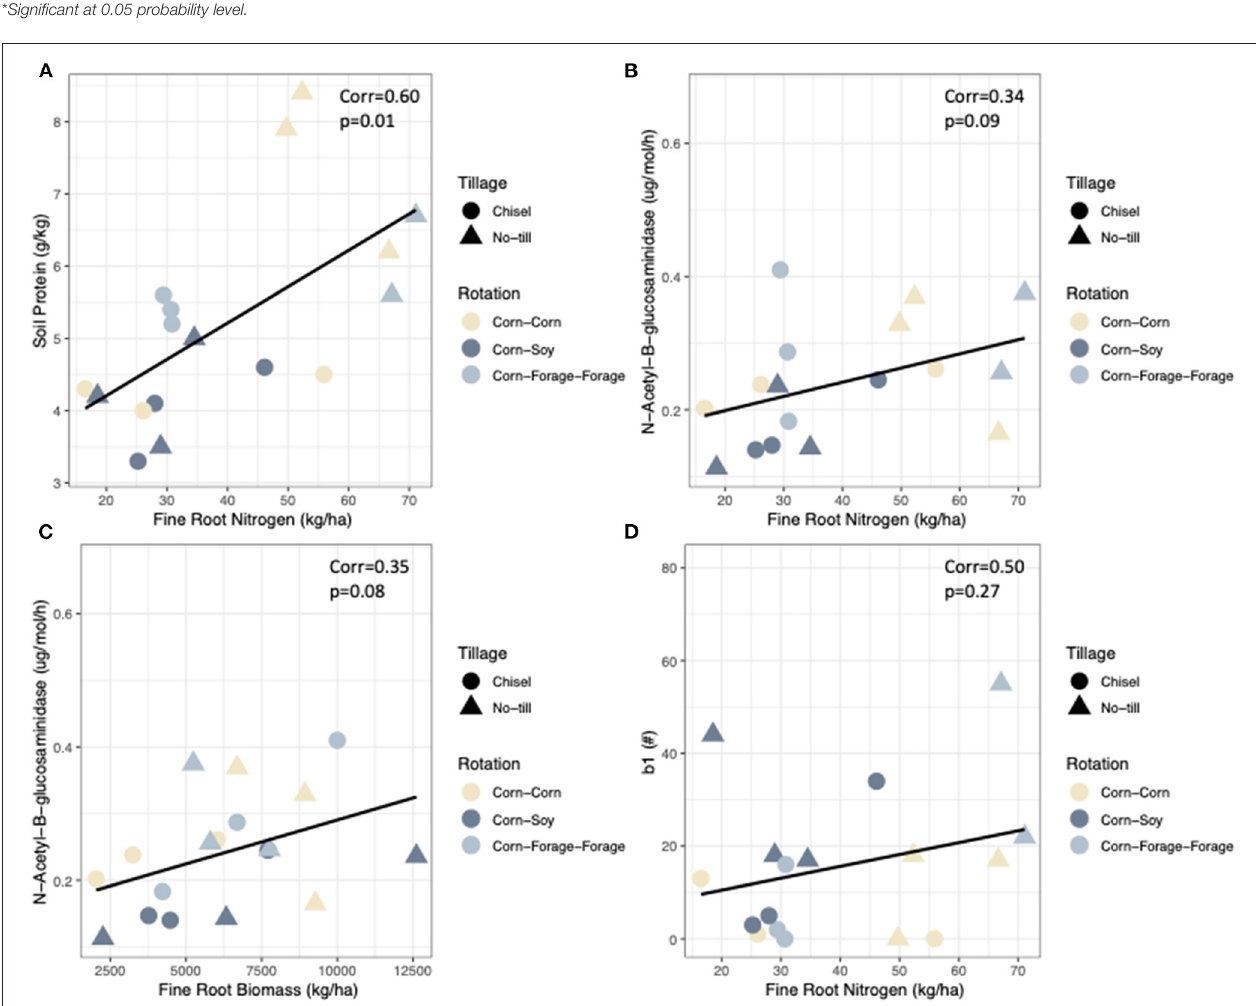
FIGURE 3 | Pearson’s correlations between key nitrogen pools across contrasting agroecosystems (A) NAG (ug/mol/h) and FRB (kg ha − 1 ). (B) NAG (ug/mol/h) and FRN (kg ha − 1 ). (C) Soil protein (g kg − 1 ) and FRN (kg ha − 1 ). (D) Enrichment opportunists ( b 1) and FRN (kg ha − 1 ). The different systems are differentiated by shapes and colors, whereby shapes reflect tillage intensity and color represents crop rotational